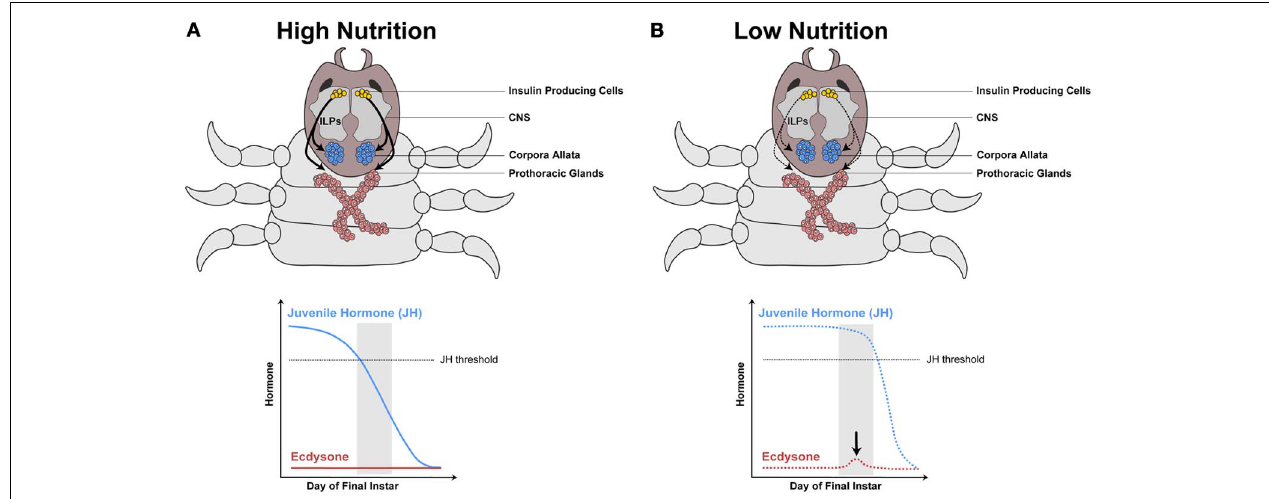
FIGURE 4 | Model hypothesizing how the IIS/TOR pathway regulates hormone synthesis in the dung beetle, Onthophagus taurus . In rich nutritional environments (A) higher concentration of insulin-like peptides (ILPs, curved black arrows) are secreted from the insulin producing cells in the central nervous system (CNS). The prothoracic glands and corpora allata grow in response to these high concentrations of ILPs, which alters the